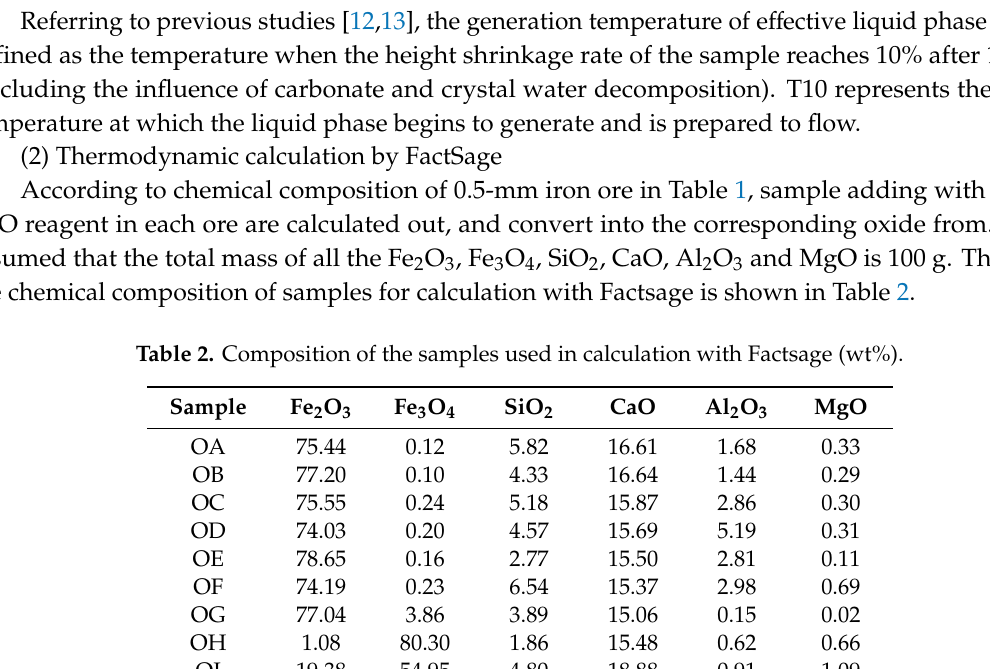
Table 2. Composition of the samples used in calculation with Factsage (wt%).